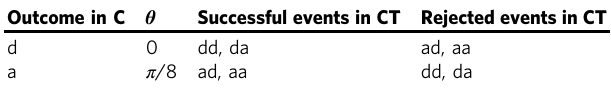
Table 1 The detection outcome patterns Outcome in C θ Successful events in CT Rejected events in